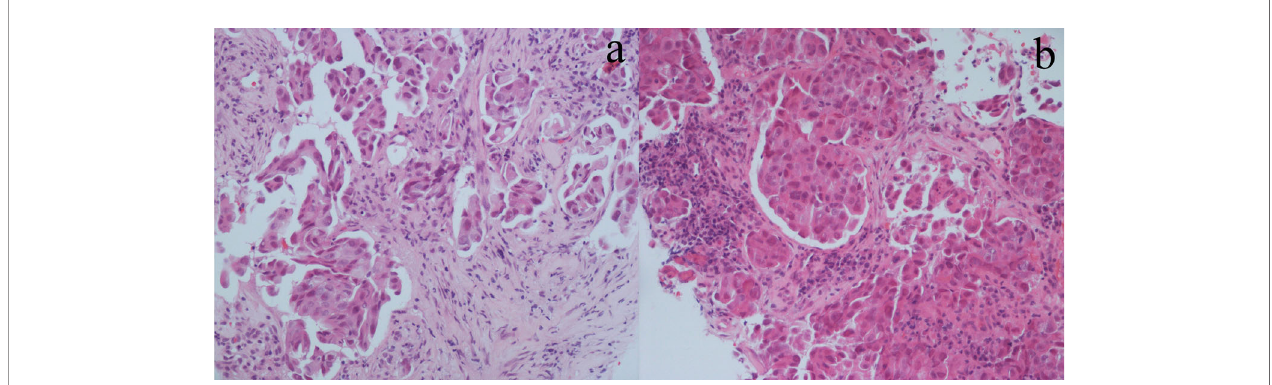
FIGURE 2 | Hematoxylin and eosin staining of the fi rst (A) and repeated (B) biopsy specimens.